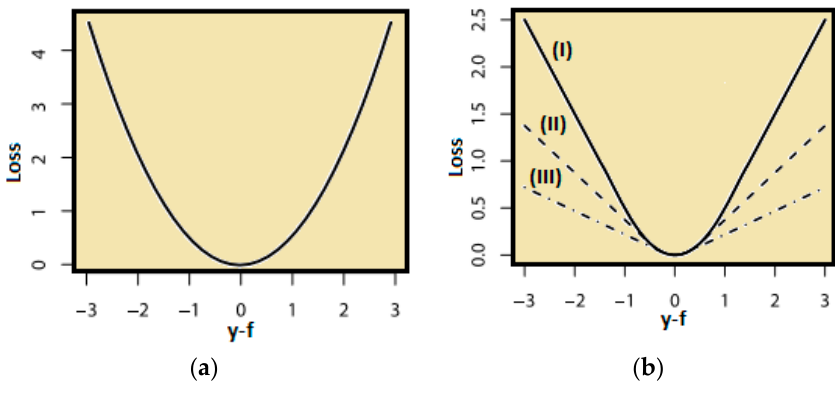
Figure 1. ( a ) Continuous loss function L2 squared; ( b ) Huber loss function.